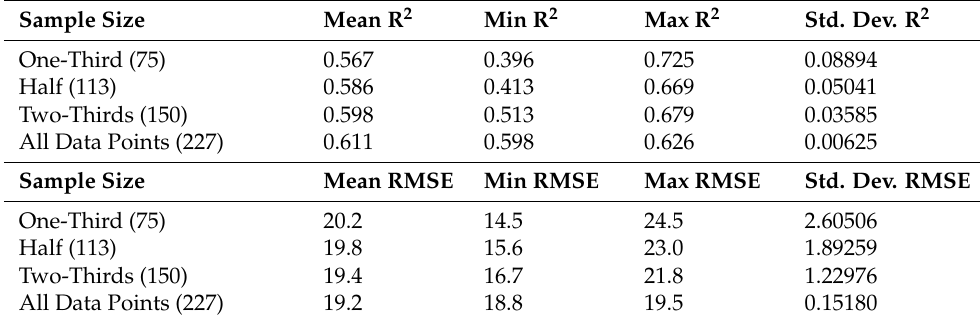
Table 3. Statistical summary of sample size